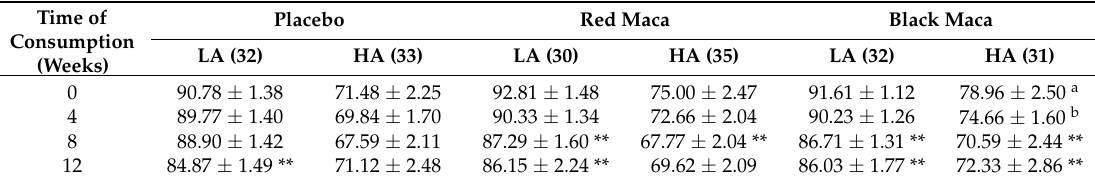
Table 2. Fasting glycemia (mg/dL) in adult human subjects who consumed spray-dried extracts of maca (red or black) or a placebo at low (LA) and high altitude